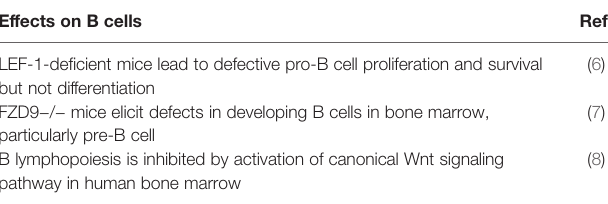
TABLE 1 | Effects of Wnt signaling pathway on B